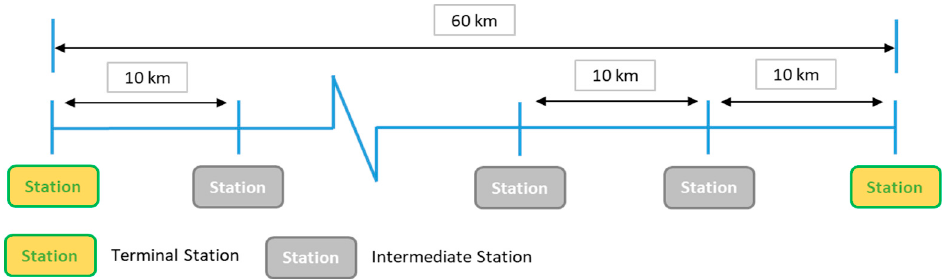
Figure 6. Schematic of the railroad track.